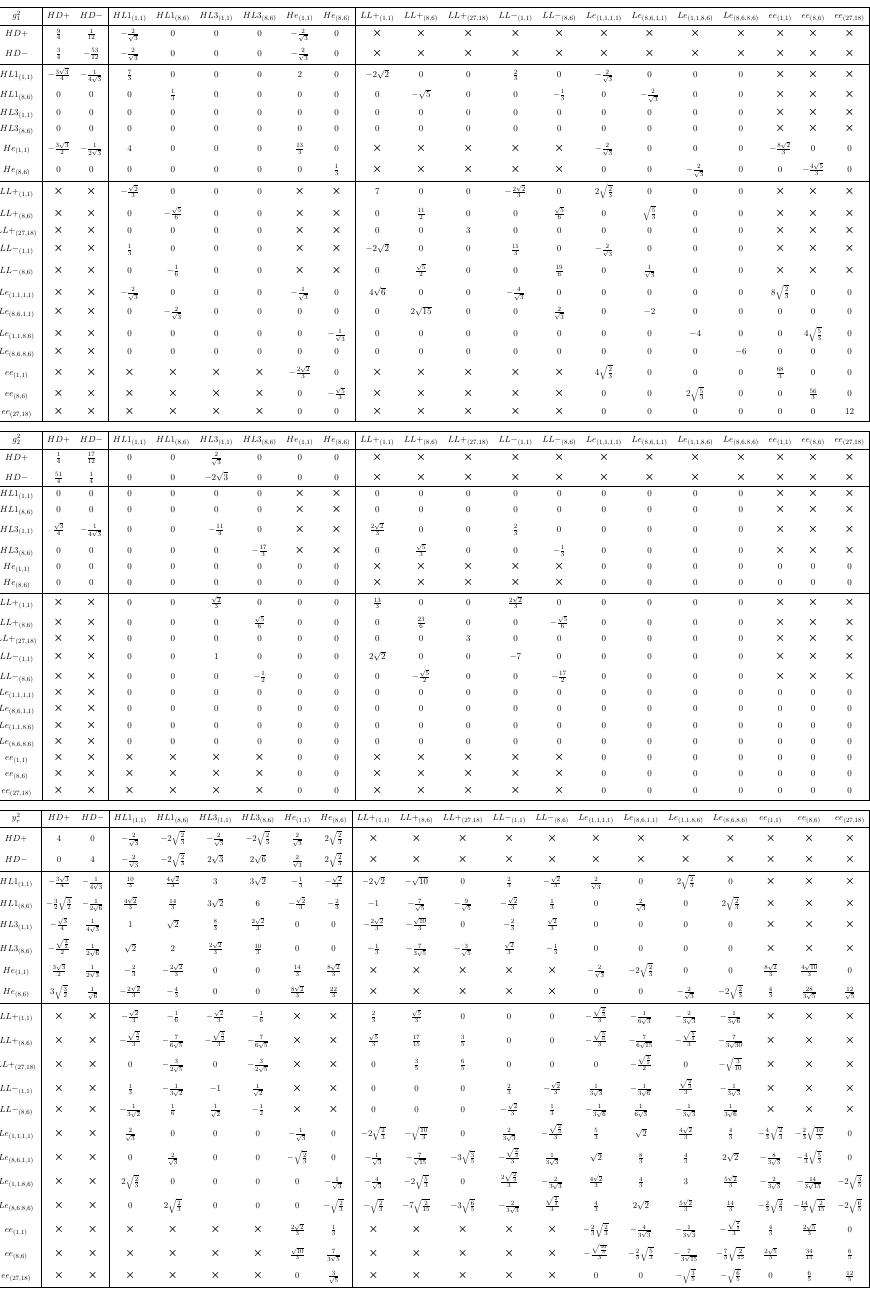
Table 10 . The gauge and Yukawa pieces of the running among the quarkless current-current operators, when electron and muon Yukawas are neglected. Shown are the 20 operators with flavour charges Y = Y = I = I = I = I = 0 , which are conserved by the running L e 3 ,L 3 ,e L e